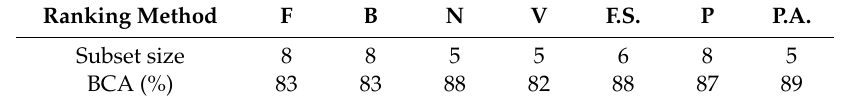
Table 5. Ranking methods performance comparison on the PsyCap dataset using Random forest.